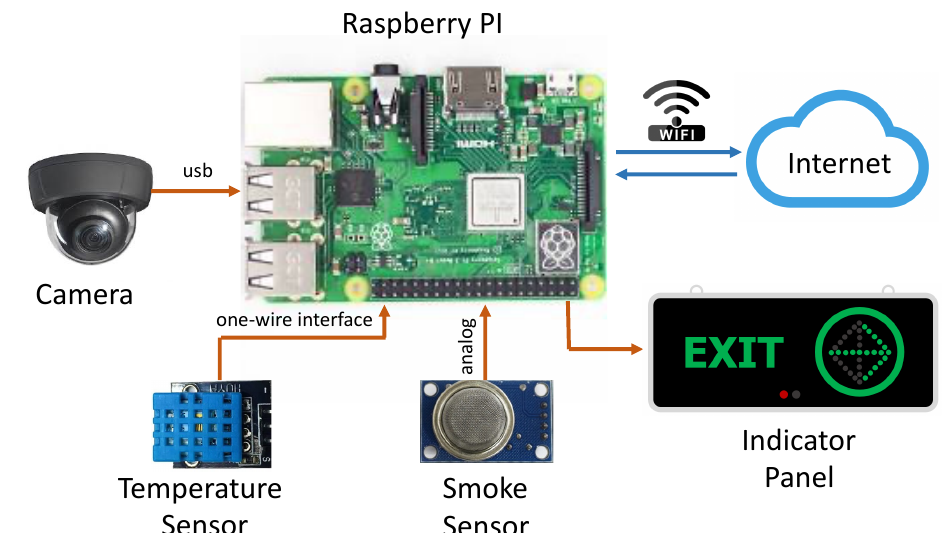
Figure 2. Hardware Components of a Smart